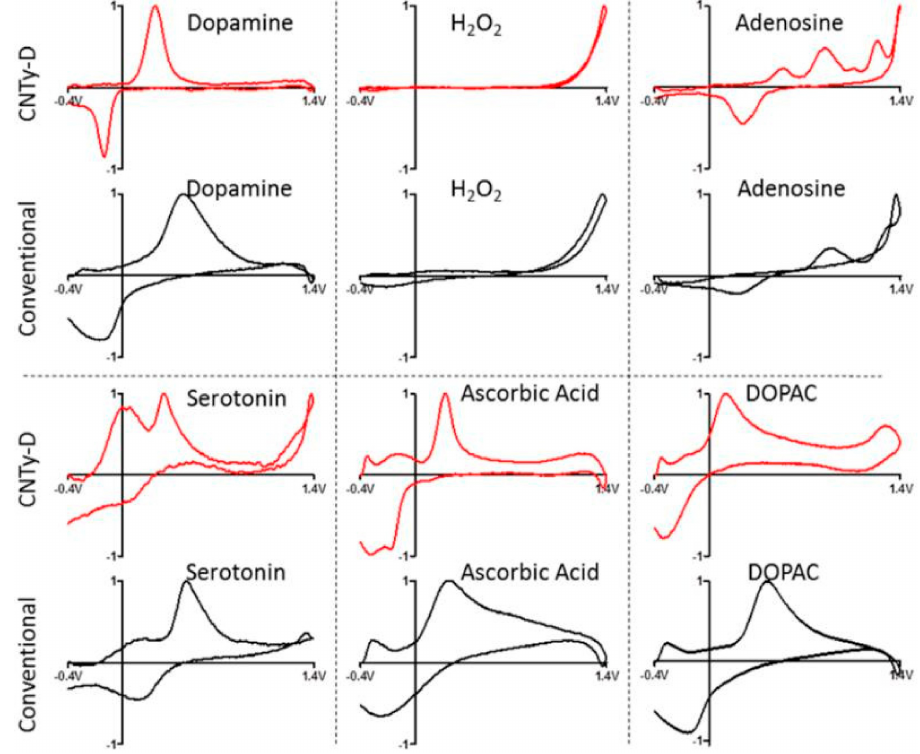
Figure 4. Fast-scan cyclic voltammetry diagram of CNT yarn disk shaped (CNTy-D) microelectrodes and conventional microelectrodes detecting different species. Reprinted with permission from [30].